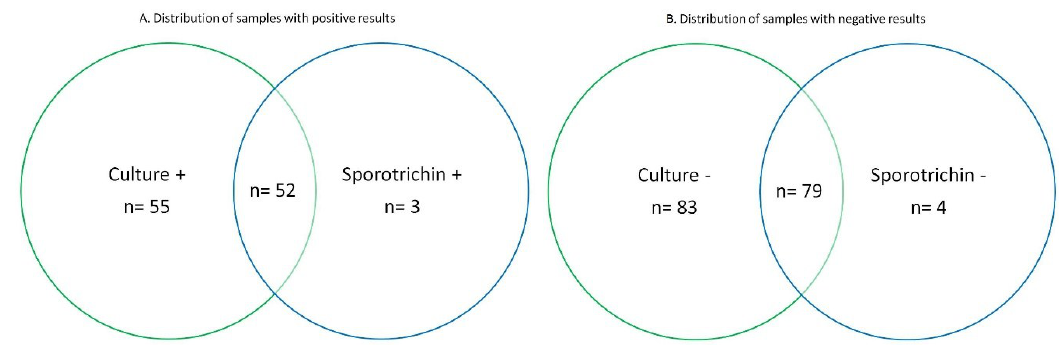
Figure 1. Venn diagram showing the distribution of positive laboratory results. + means positive, and − means negative.